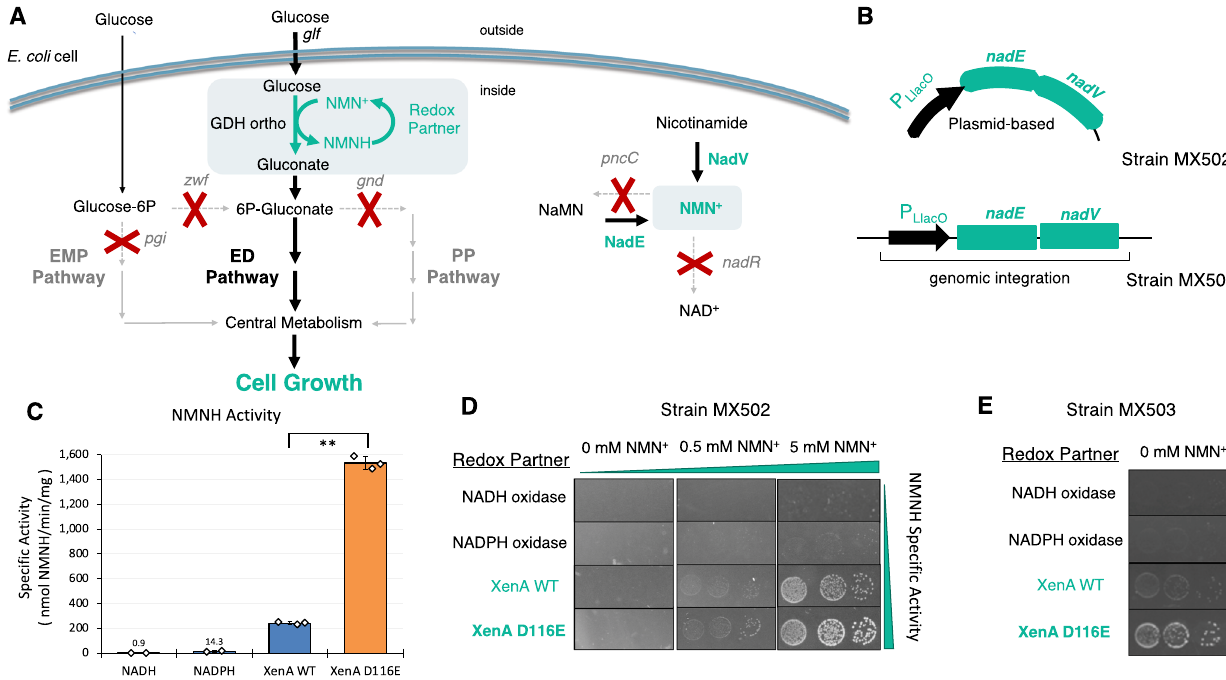
Fig. 1 | NMN + regeneration drives dynamic glucose-dependent cell growth.